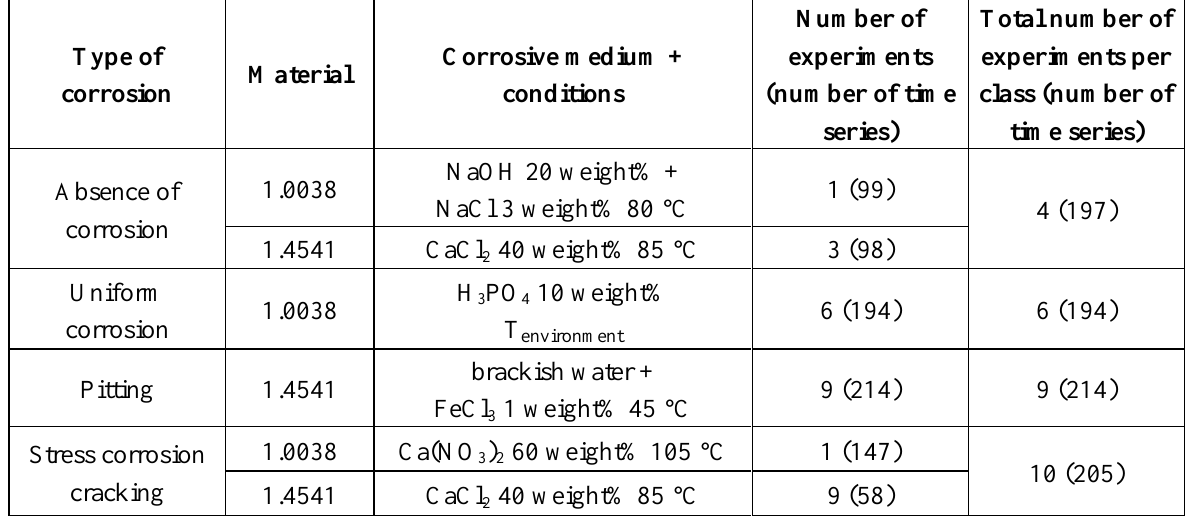
Table 1. The steel types, the corrosive medium and the number of different experiments considered. The data was obtained from